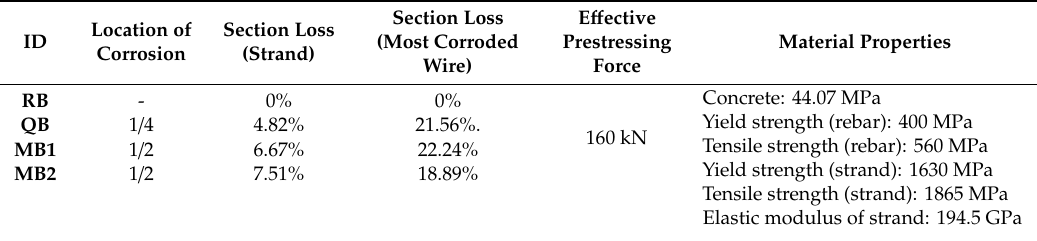
Table 2. Beam test